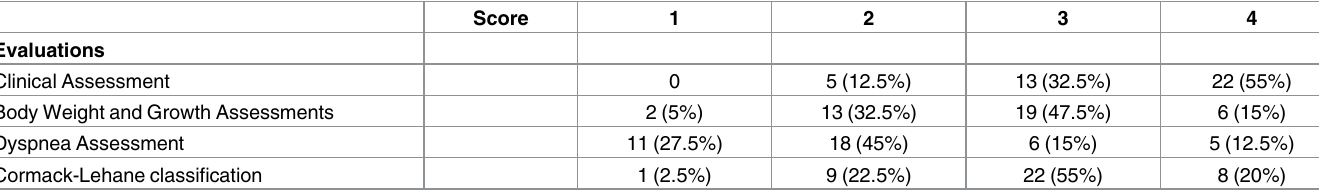
Table 3. Patient distribution based on comprehensive assessments